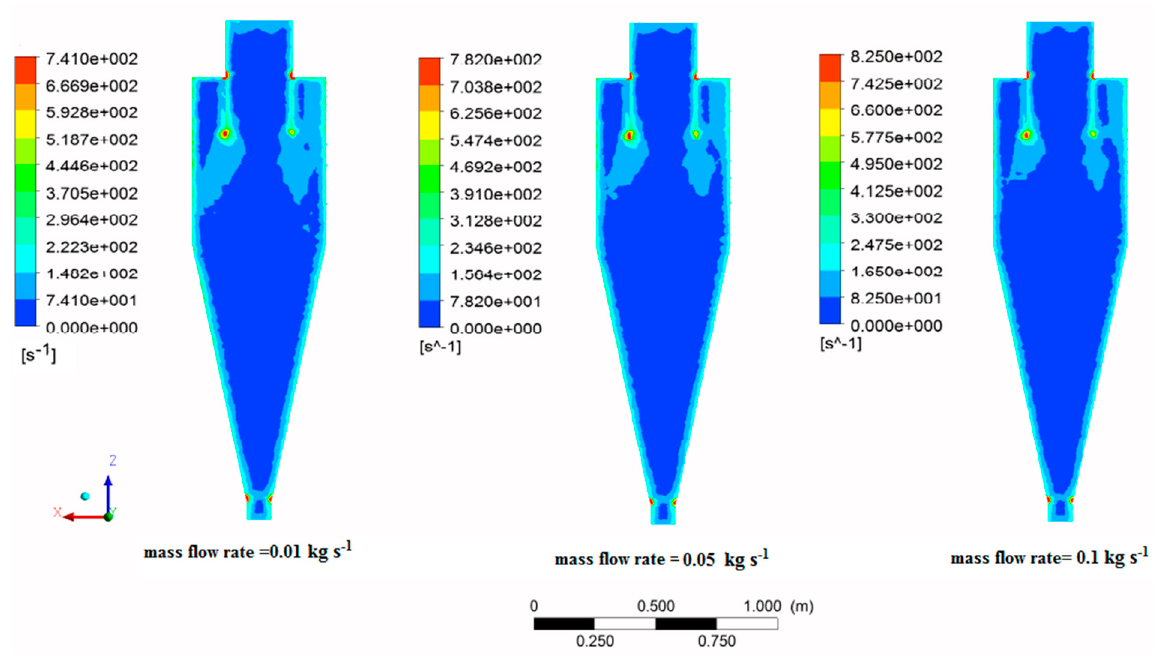
Figure 16. Strain rate contours in various mass flow rates.